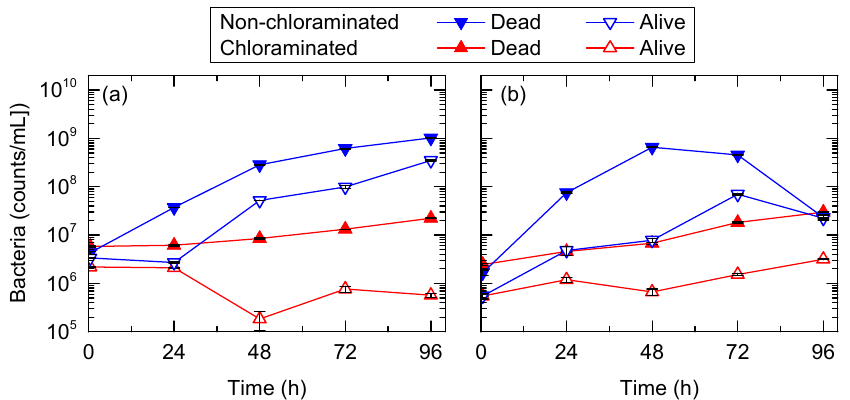
Figure 9. Dead and alive bacterial counts in the chloraminated and non-chloraminated FO systems during the ( a ) first and ( b ) second pre-concentration tests using primary wastewater effluent. Error bars show the standard deviation of two replicate experiments.